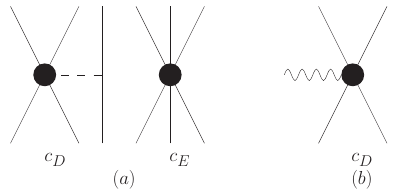
Fig. 2. Contact and one-pion exchange plus contact interaction ( a ), and contact MEC ( b ) terms of χ PT. Figure taken from [25].